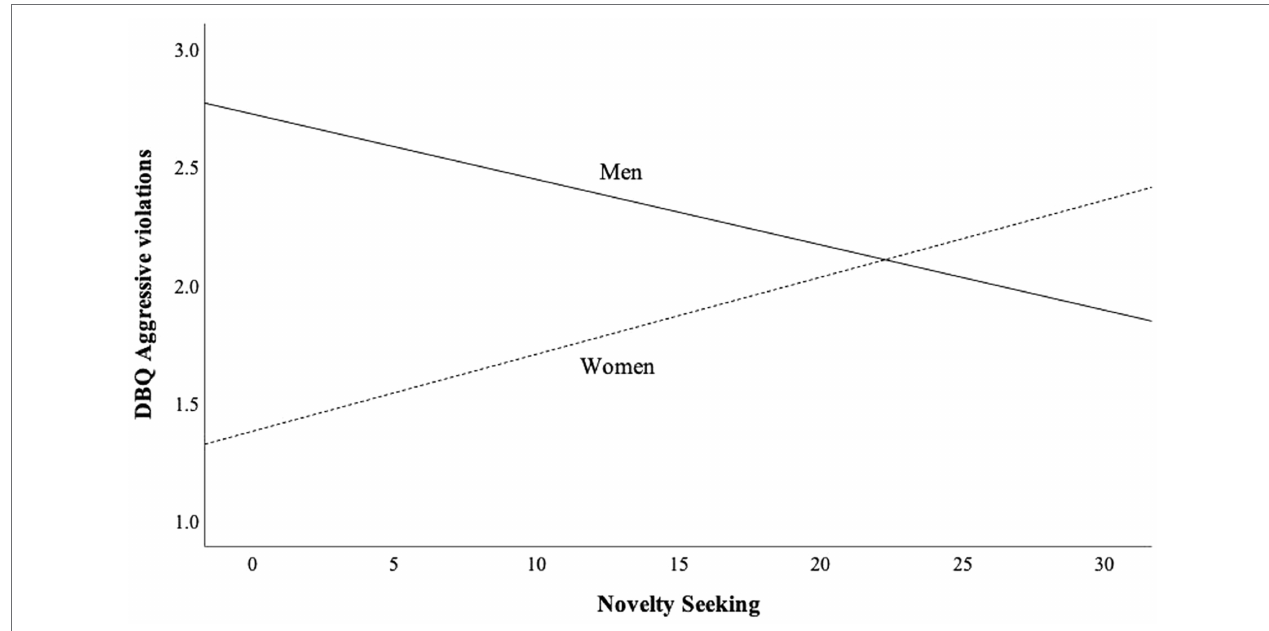
FIGURE 1 | Moderation effect of gender on the relationship between novelty seeking (NS) and aggressive violations